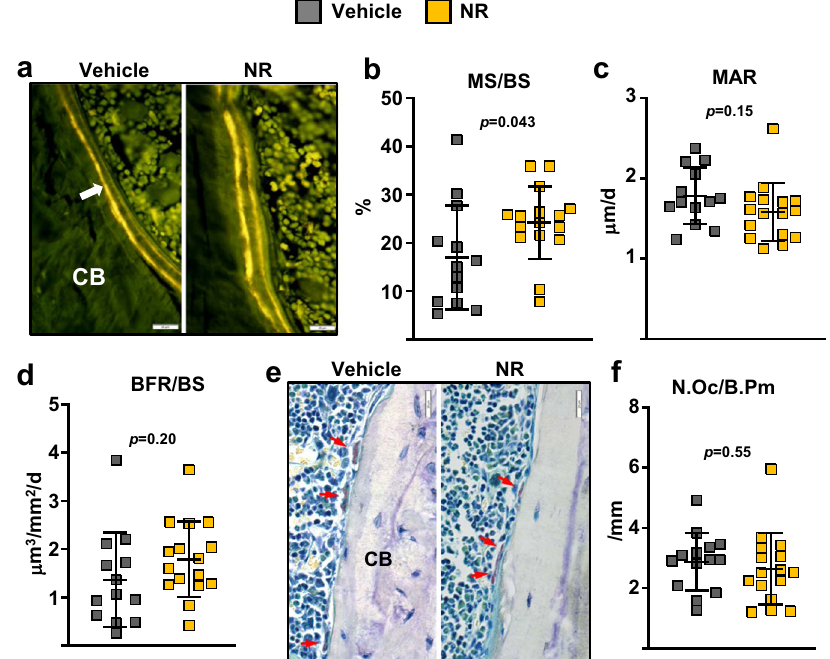
Fig. 4 Mice administered with NR had higher mineralizing surface. a Representative photomicrographs of endocortical bone surface labeled with tetracycline ( fl uorescent green) in longitudinal undecalci fi ed femur sections from 20-month-old female mice treated without or with 12 mM NR (×40 magni fi cation). b Mineralizing surface, c mineral apposition rate, and d bone formation rate determined by tetracycline labels ( n = 13 – 16 mice/group, one section per mouse was analyzed). e Representative microphotographs of femur sections as in a stained with TRAP. Red arrows indicate osteoclasts (×40 magni fi cation). f Osteoclast number per bone perimeter determined in sections stained with TRAP ( n = 13 – 16 mice/group, one section per mouse was analyzed). Data represent mean ± SD; p values by two-tailed unpaired t